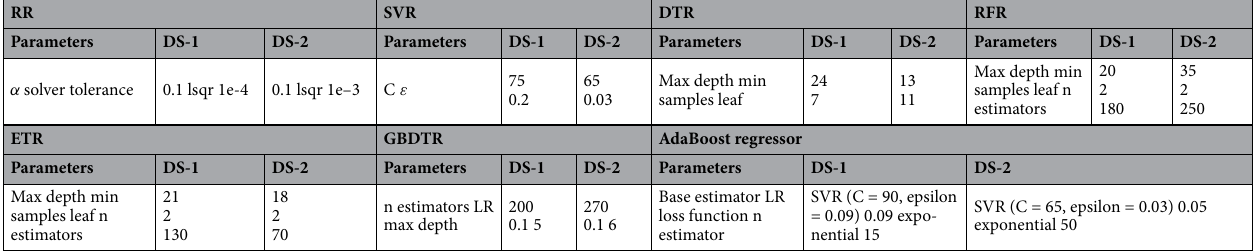
Table 1. Tuned hyper-parameters of the ML models used to train the two data sets, DS-1 and DS-2.